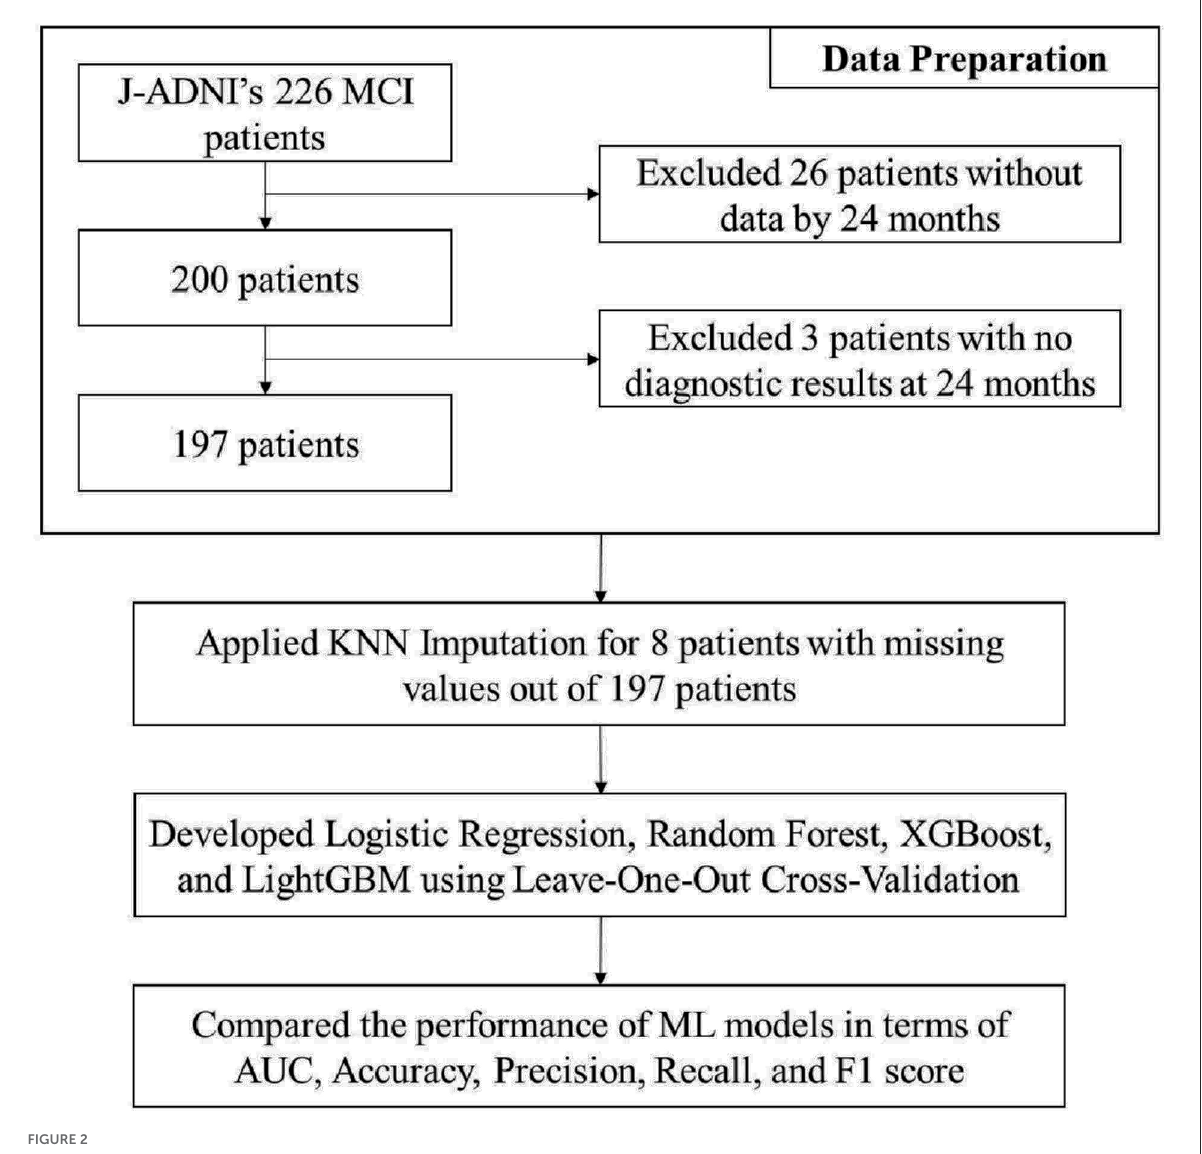
FIGURE2 Study population and overall procedure for the